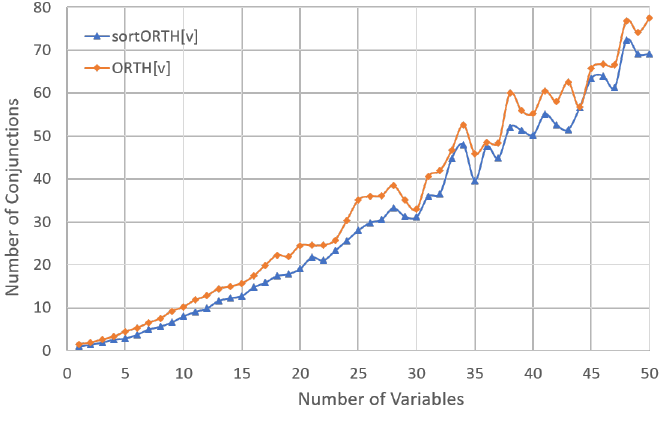
Fig. 7. Average number of conjunctions in the orthogonal